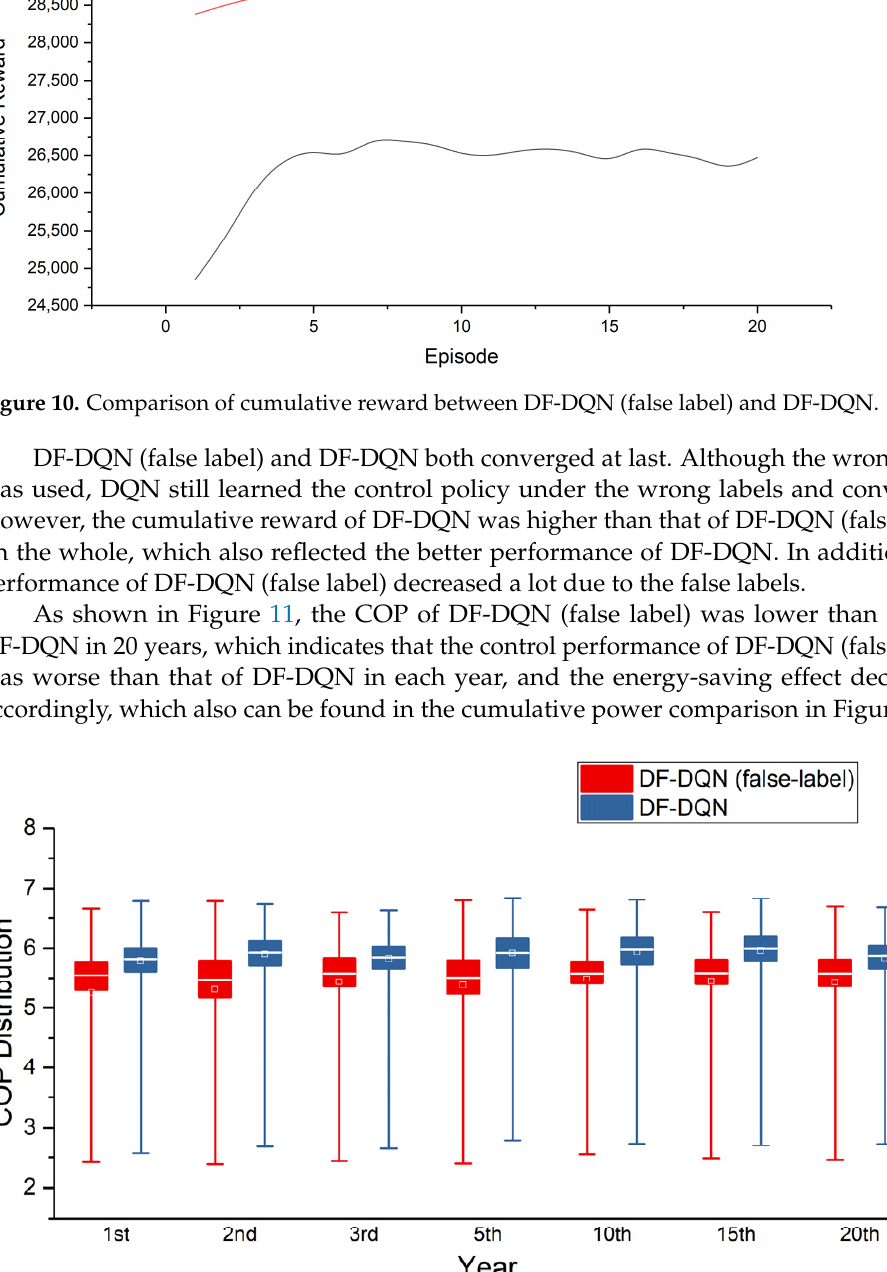
Figure 12. Comparison of cumulative power between DF-DQN and DF-DQN (false label). We compared the energy-saving effect of these two methods, and used the baseline control method of the system as a benchmark. The partial energy-saving effect compari- son can be found in Table 2. Table 2. Partial energy-saving effect comparison result. Energy Saving (Compared to Baseline Control) Year